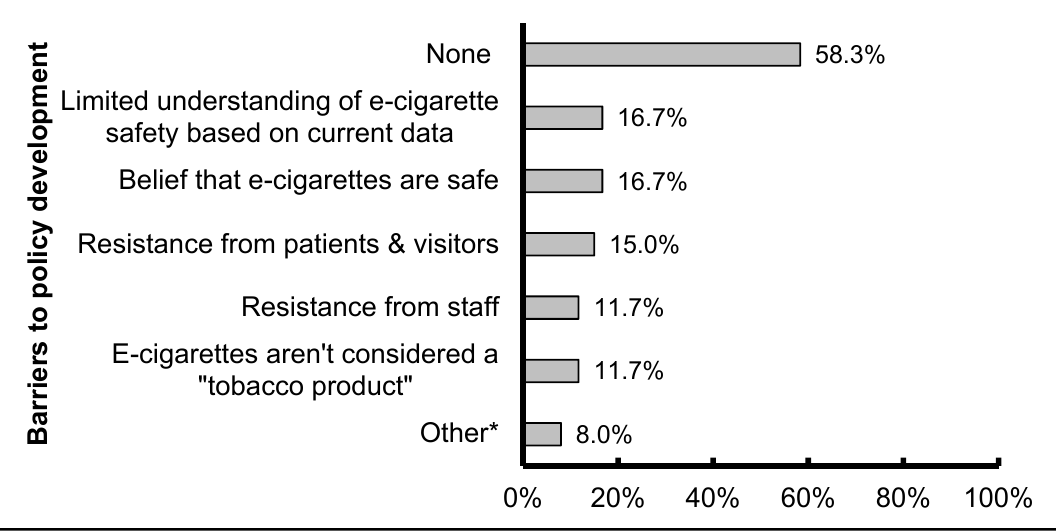
Figure 3. Barriers experienced when developing a policy regulating the use of e-cigarettes ( n = 60). * Other includes concerns that enforcing e-cigarette policy would be too difficult (3%); legal concerns (3%); and cost of implementation (2%).